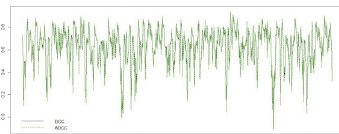
Fig. 10. Dynamic Conditional Corre- lation at D3 Scale